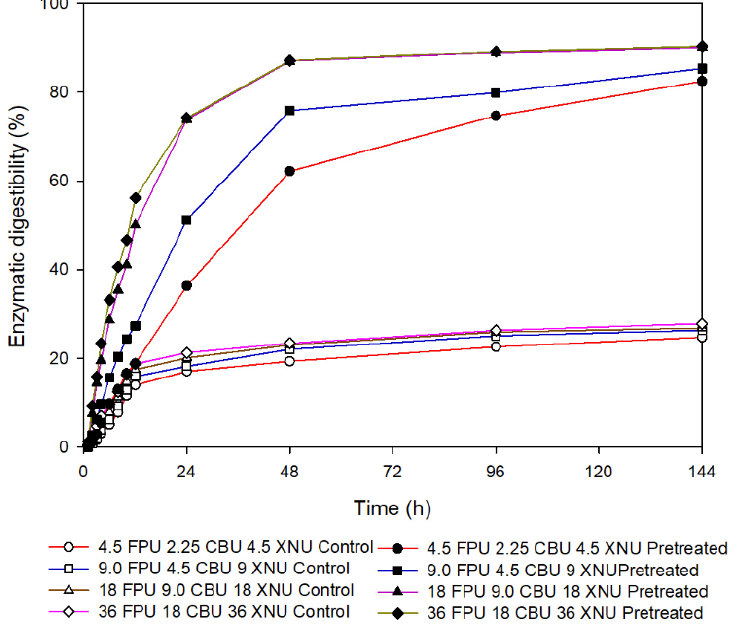
Figure 3. Enzymatic hydrolysis of orange peel. Filled symbols represent pretreated group and not filled symbols represent control group (non-pretreatment).